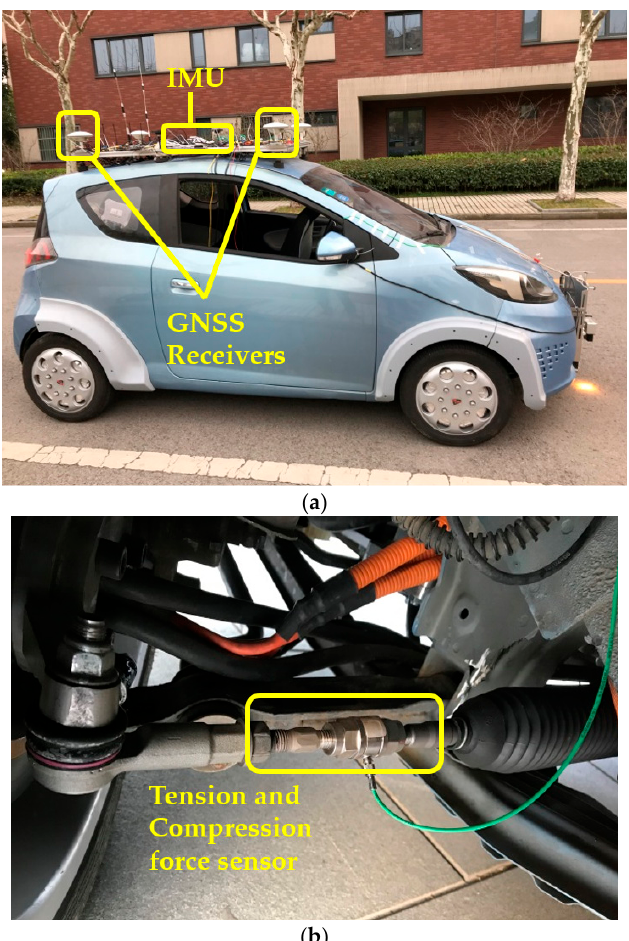
Figure 5. Test vehicle implementation: ( a ) test vehicle; ( b ) steering tie rod with a tension and compression force sensor.